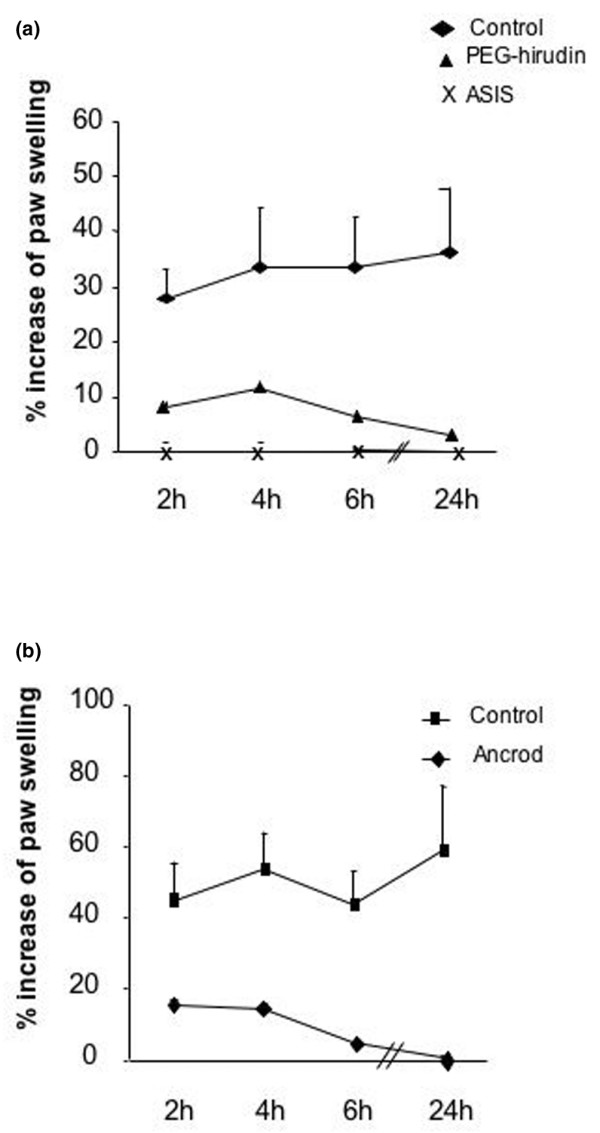
Role of hirudin, factor VII inhibitor and ancrod in soluble tissue factor-induced footpad inflammation. (a) Wildtype mice treated with PEG-hirudin (n = 5) or with ASIS (active-site inhibited activated factor VII, n = 5), or untreated mice (n = 7), were injected with 1 μg soluble tissue factor. Results from all treated groups were significantly reduced (P < 0.05 by t test) compared with the control group. (b) Wildtype mice were treated with ancrod (n = 7) or with phosphate-buffered saline (n = 7) and then injected with 1 μg soluble tissue factor. Results from ancrod-treated mice are significantly different from the control group, at all time points (P < 0.05 by t test).